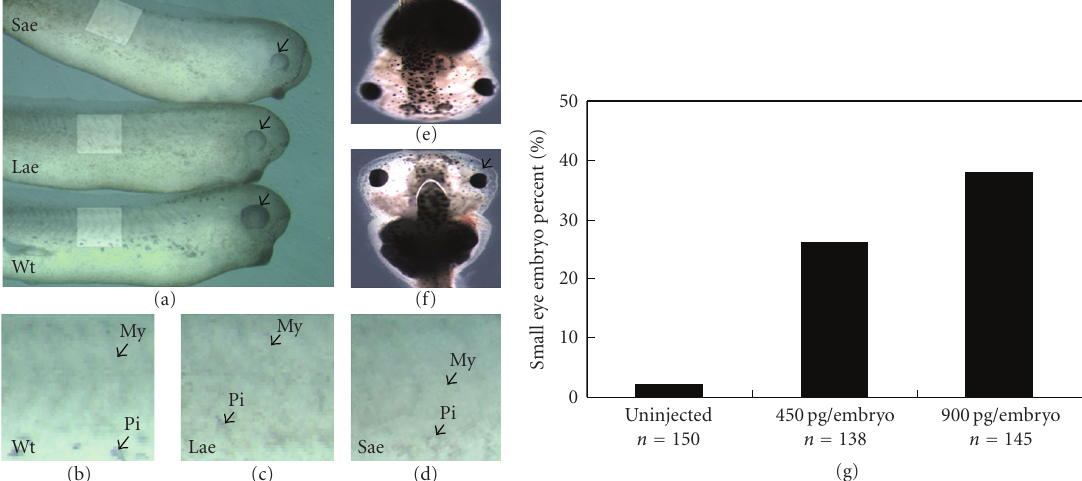
Figure 3: Developmental defects in Xenopus embryos caused by microinjection of xPNAS-4. Embryos were injected once into the dorsal marginal zone at the one-cell stage with 450 pg or 900 pg of xPNAS-4 mRNA. (a) Lateral view of stage 35 tadpoles showing (bottom to top) an una ff ected embryo (Wt, bottom); a mildly a ff ected embryo (Lae, middle) and a strongly a ff ected embryo (Sae, upper). Arrows indicate embryos’ eyes. (b), (c), and (d) are magnified views from local regions in the pictures. Abbreviations: Wt, wild type; Lae, mildly a ff ected embryo; Sae, strongly a ff ected embryo; My, myotome; Pi, pigment. (e) Dorsal view of an uninjected stage 43 embryo. (f) Dorsal view of stage 43 embryo which was injected with 900 pg of xPNAS-4 mRNA. (g) Graphical representation of the percent of embryos injected with xPNAS-4 mRNA with the small eye phenotype at stage 35 ( n = the number of embryos in each